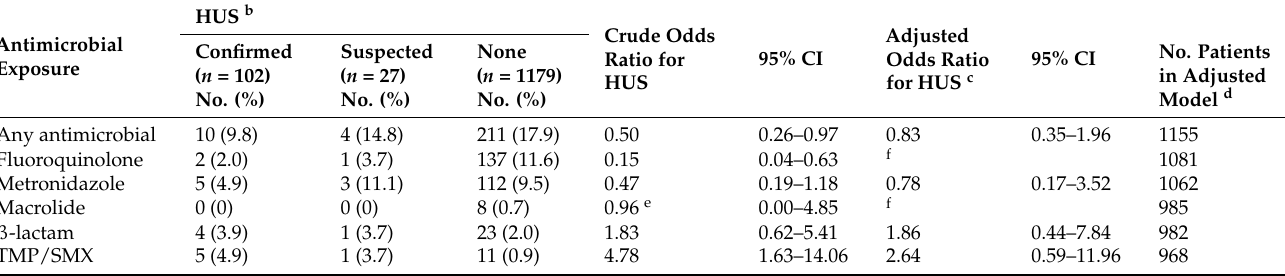
Table 5. Frequency of antimicrobial exposure by HUS status and the association between recorded antimicrobial exposures during the first 3 days of illness and the development of confirmed HUS a